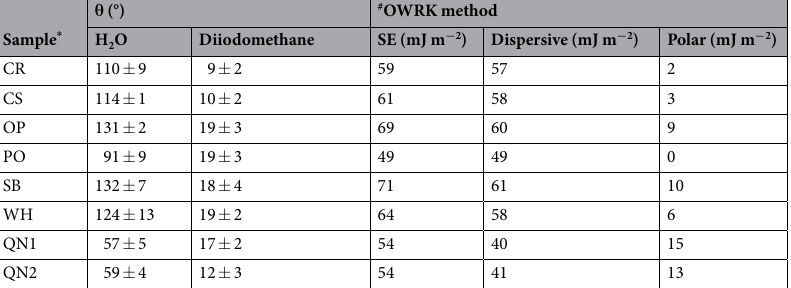
Table 4. Contact angles ( θ ) formed by drops of H 2 O and diiodomethane, and polar and dispersive components of the surface energy for the different biochar and soil samples. * CR = charcoal fines; CS = coconut shell; OP = orange peel; PO = palm oil bunch; SB = sugarcane bagasse; WH = water hyacinth; QN1 = quartzarenic neosol soil 1; QN2 = quartzarenic neosol soil 2. # Owens-Wendt-Rabel-Kaelble